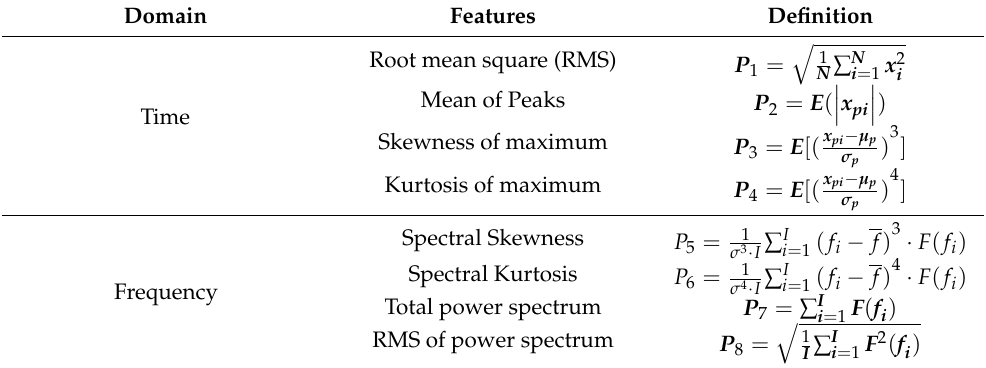
Table 2. Symptom parameters used in an in-wheel motor diagnosis system.